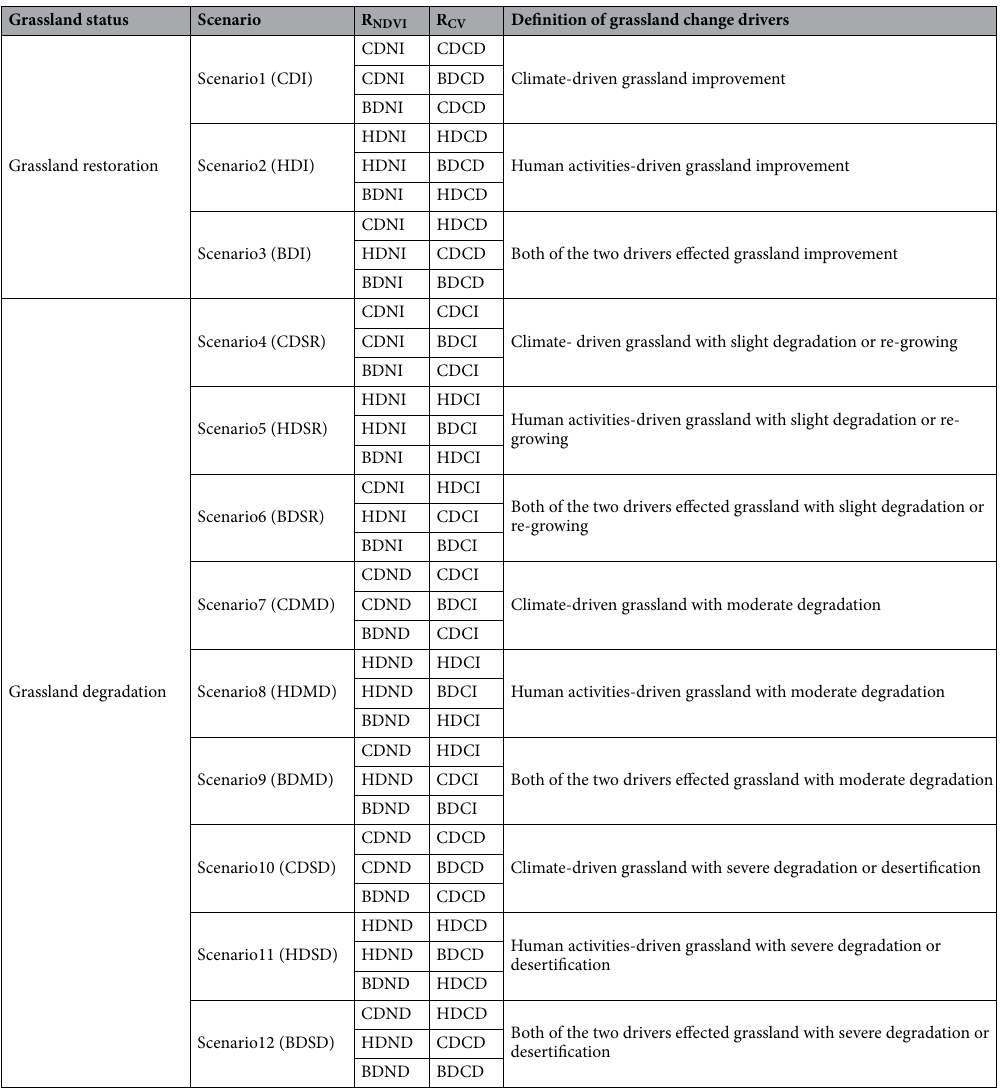
human activities on CV NDVI ; CDNI: Climate-driven NDVI increase; BDNI: Both of the two drivers effected NDVI increase; HDNI: Human activities-driven NDVI increase; CDND: Climate-driven NDVI decrease; BDND: Both of the two drivers effected NDVI decrease; HDND: Human activities-driven NDVI decrease; CDCI: Climate-driven CV NDVI increase; BDCI: Both of the two drivers effected CV NDVI increase; HDCI: Human activities-driven CV NDVI increase; CDCD: Climate-driven CV NDVI decrease; BDCD: Both of the two drivers effected CV NDVI decrease; HDCD: Human activities-driven CV NDVI